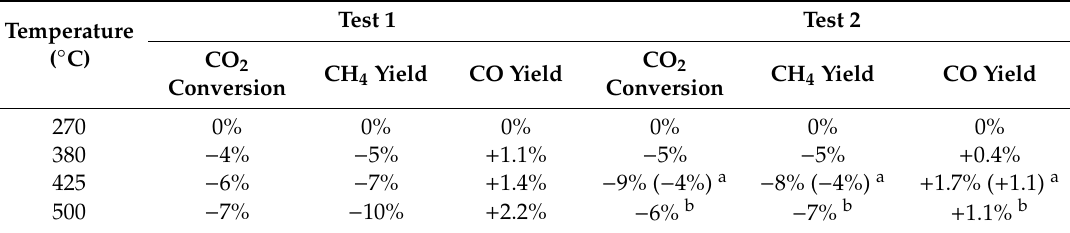
Table 1. CO 2 conversion and Methane yield variation after 100 h of time on stream (Tests 1 and 2 refer to Figure 1 and 2 conditions, respectively).